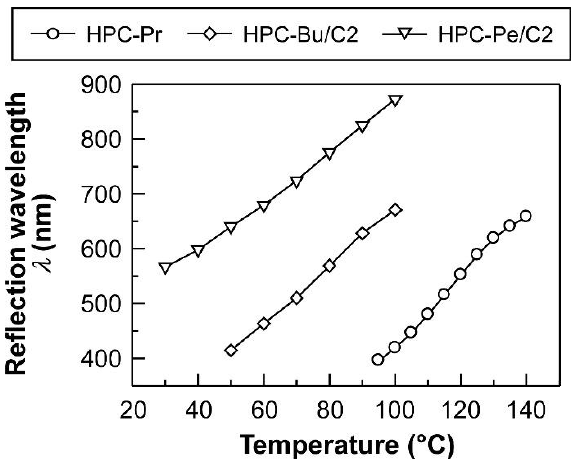
Figure 4. Temperature dependences of the reflection peak wavelengths of HPC-Pr, HPC-Bu/C2, and HPC-Pe/C2.